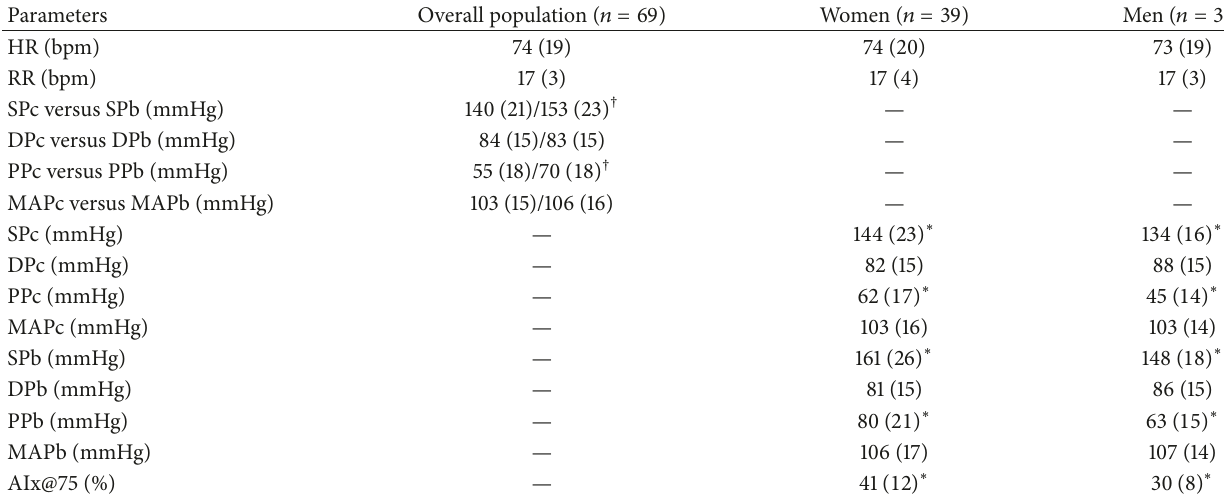
Table 2: Characteristics of the hemodynamic parameters of the groups.